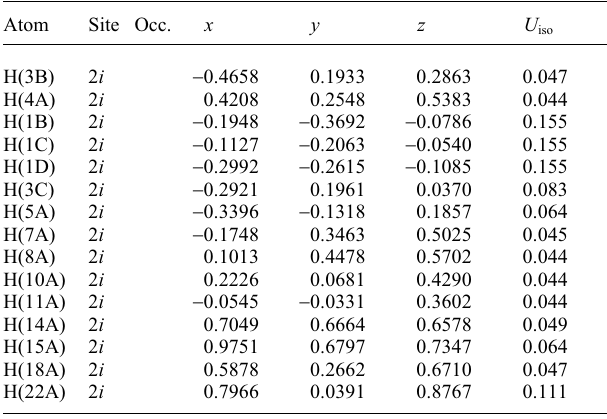
Table 2. Atomic coordinates and displacement parameters (in Å 2 )